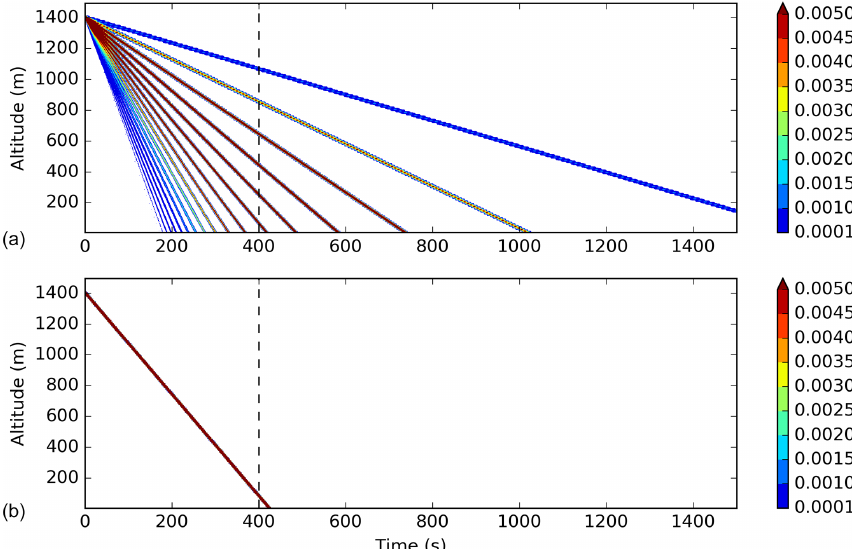
Figure 10. Time evolution of the vertical profile of rain mixing ratio (the color scale represents the mixing ratio in gkg − 1 ) for a bin box- Lagrangian scheme (a) and a bulk box-Lagrangian scheme (b)